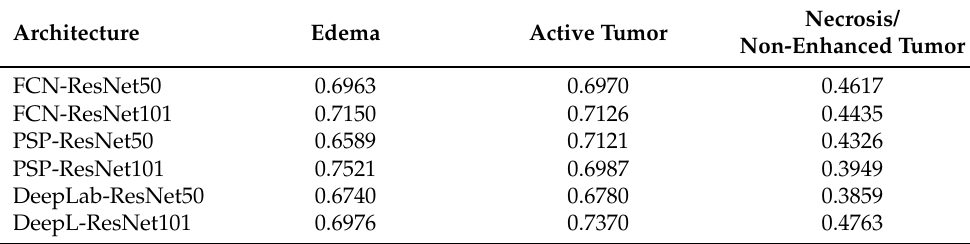
Table 3. Dice for Different Types of Tumor